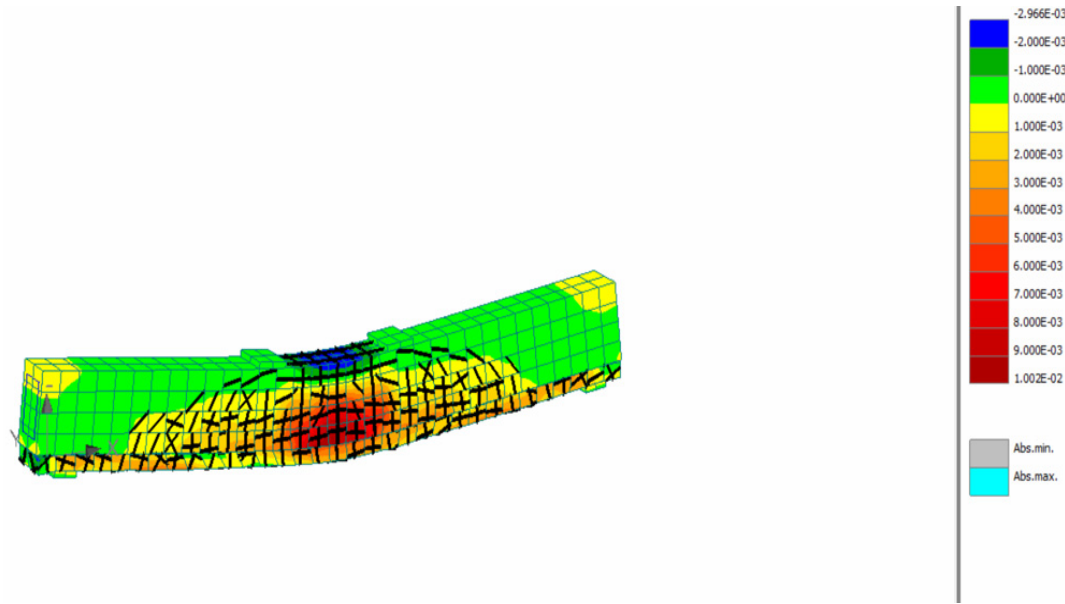
Figure 17. Crack and strain distribution of the SFRRC strengthened beam . The load mid-span deflection of the SFRRC strengthened beam (ST_0.8 MPa) is compared with the respective experimental results of the beam strengthened with conventional reinforced concrete layer (ST_RC) and the initial beam prior to strengthening (IB) (Figure 18).